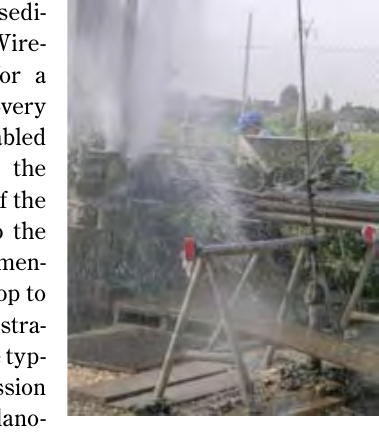
Figure 2. Blowout event.